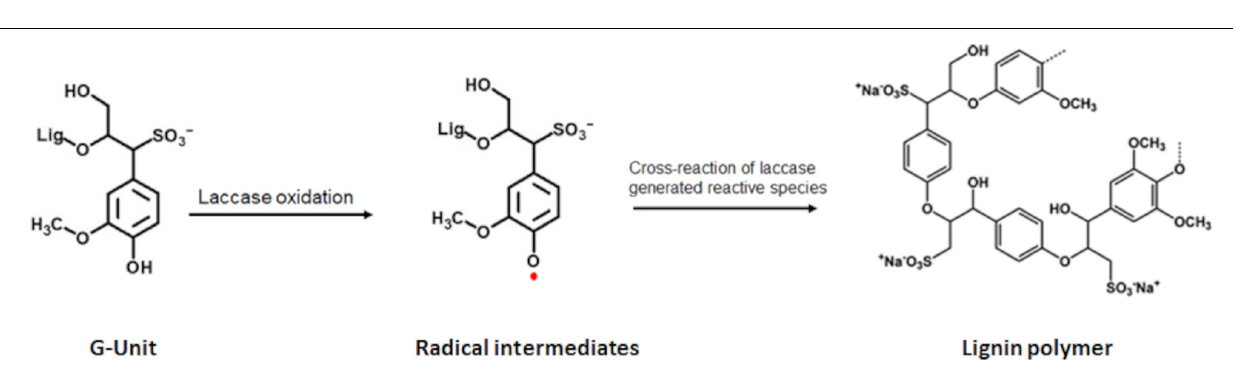
FIGURE 2 | Scheme of laccase catalyzed oxidation of lignin. Exemplary shown for the G-unit. Upon laccase oxidation radicals are formed which can cross react with each other thereby forming lignin